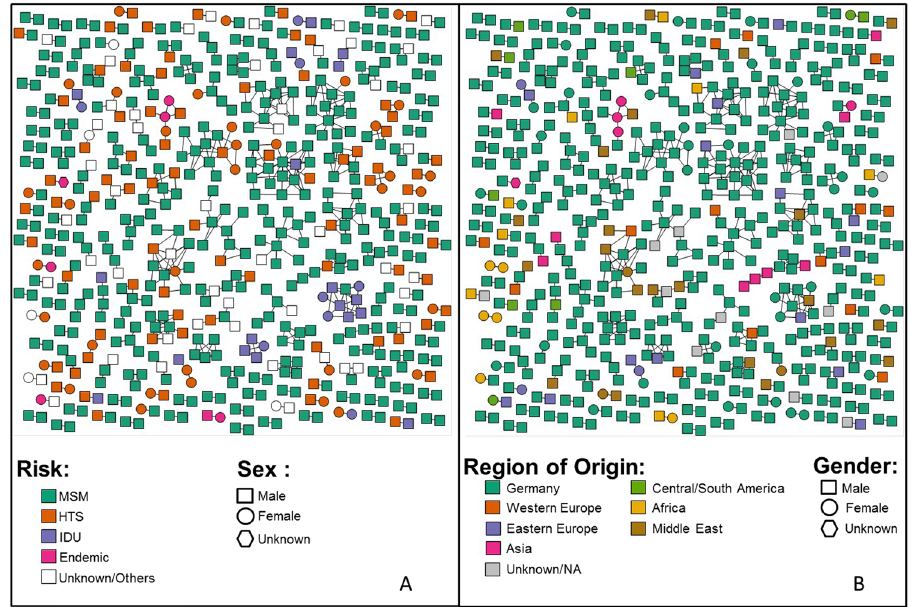
Figure 3. HIV Transmission Network by Risk Factor and Country of Origin. ( A ) Nodes are coloured by their reported risk factor in green (men who have sex with men, MSM), orange (heterosexual [HTS]), purple (injection drug use [IDU]) and pink (endemic), respectively. ( B ) Here, nodes are coloured according to the country/region/continent of origin in green (Germany), orange (Western Europe), purple (Eastern Europe), pink (South-East Asia), yellow (Africa), brown (Middle-East), and red (Central and South